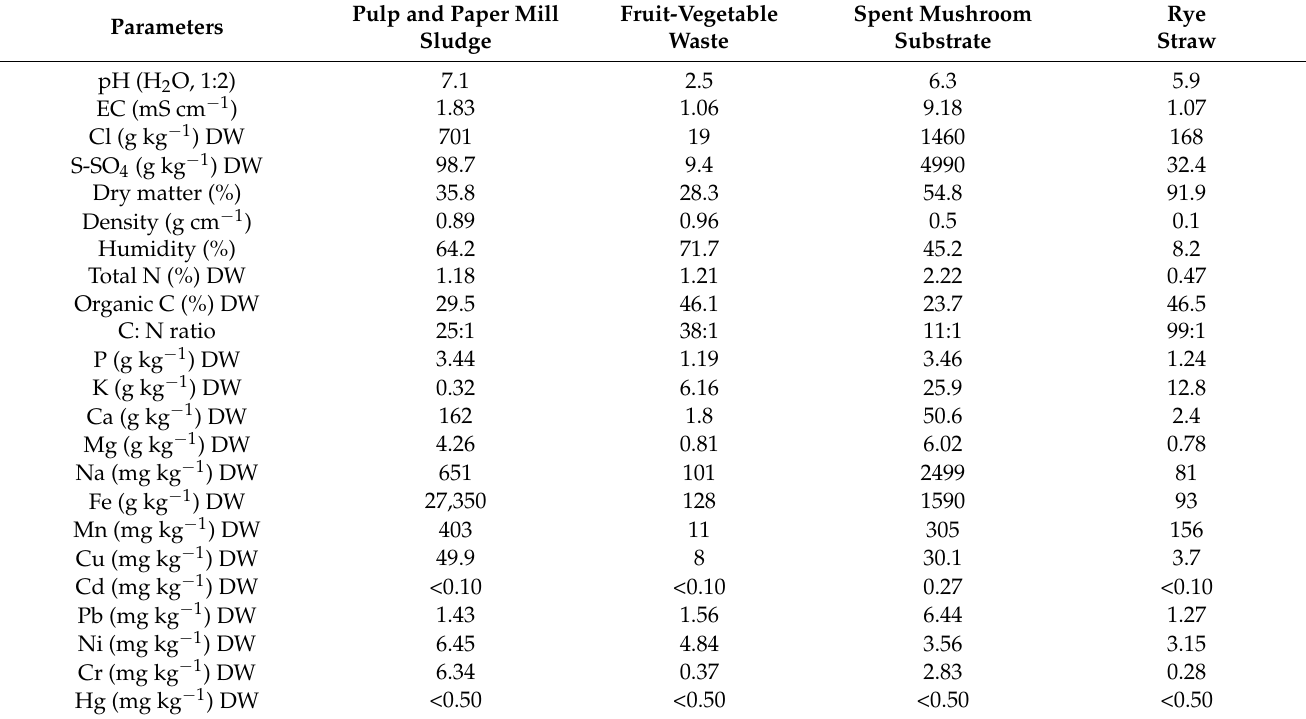
Table 1. Physical and chemical properties of waste materials used for